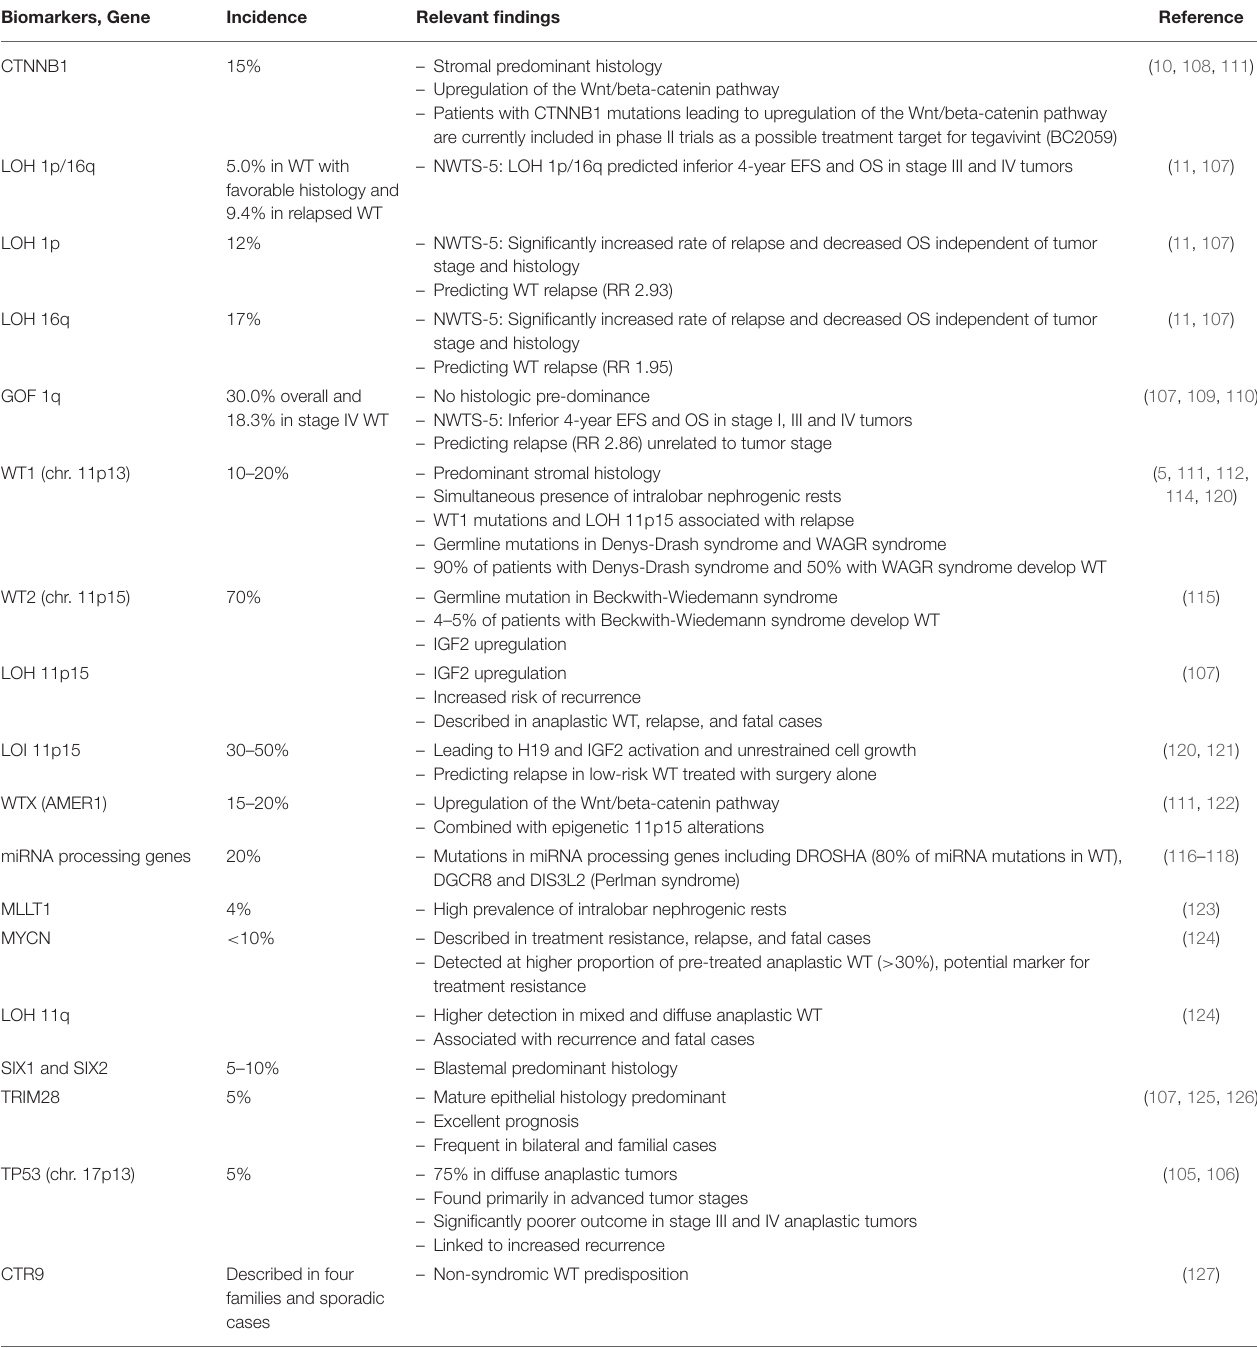
TABLE 4 | List of selected biomarkers with potential relevance for WT prognosis and/or tumorigenesis. Biomarkers,